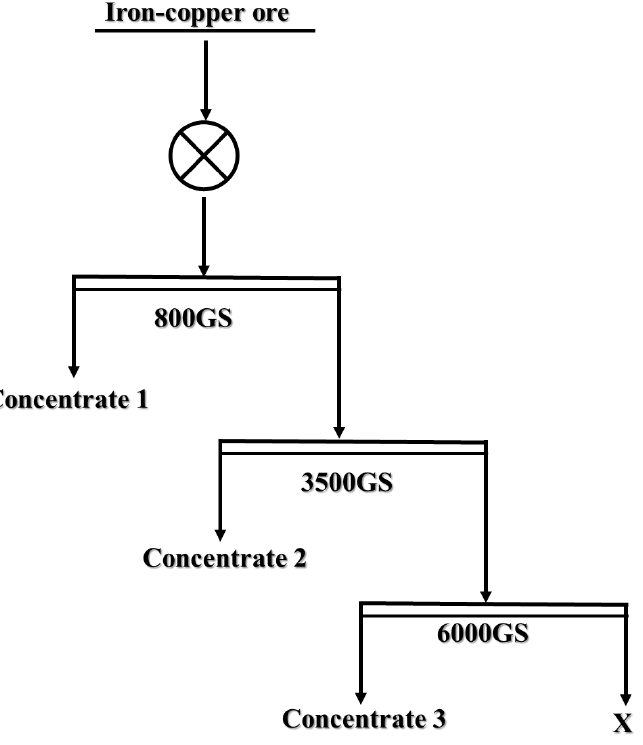
Figure 2. Magnetic separation process flowsheet of COBL ore.